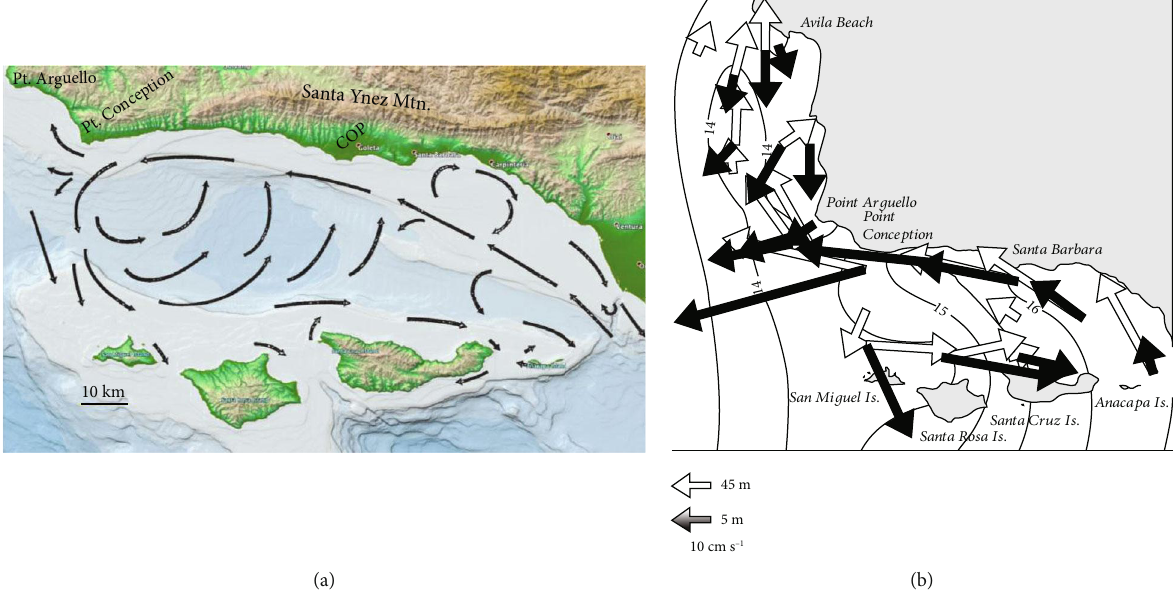
Figure 21: (a) Santa Barbara Channel bathymetry and generalized currents. Adapted from Divins and Metzger [261] and Kolpack [236], respectively. (b) Annually averaged temperature contours and annual mean current at 5 and 45m depth. Adapted from Winant et al. [237].